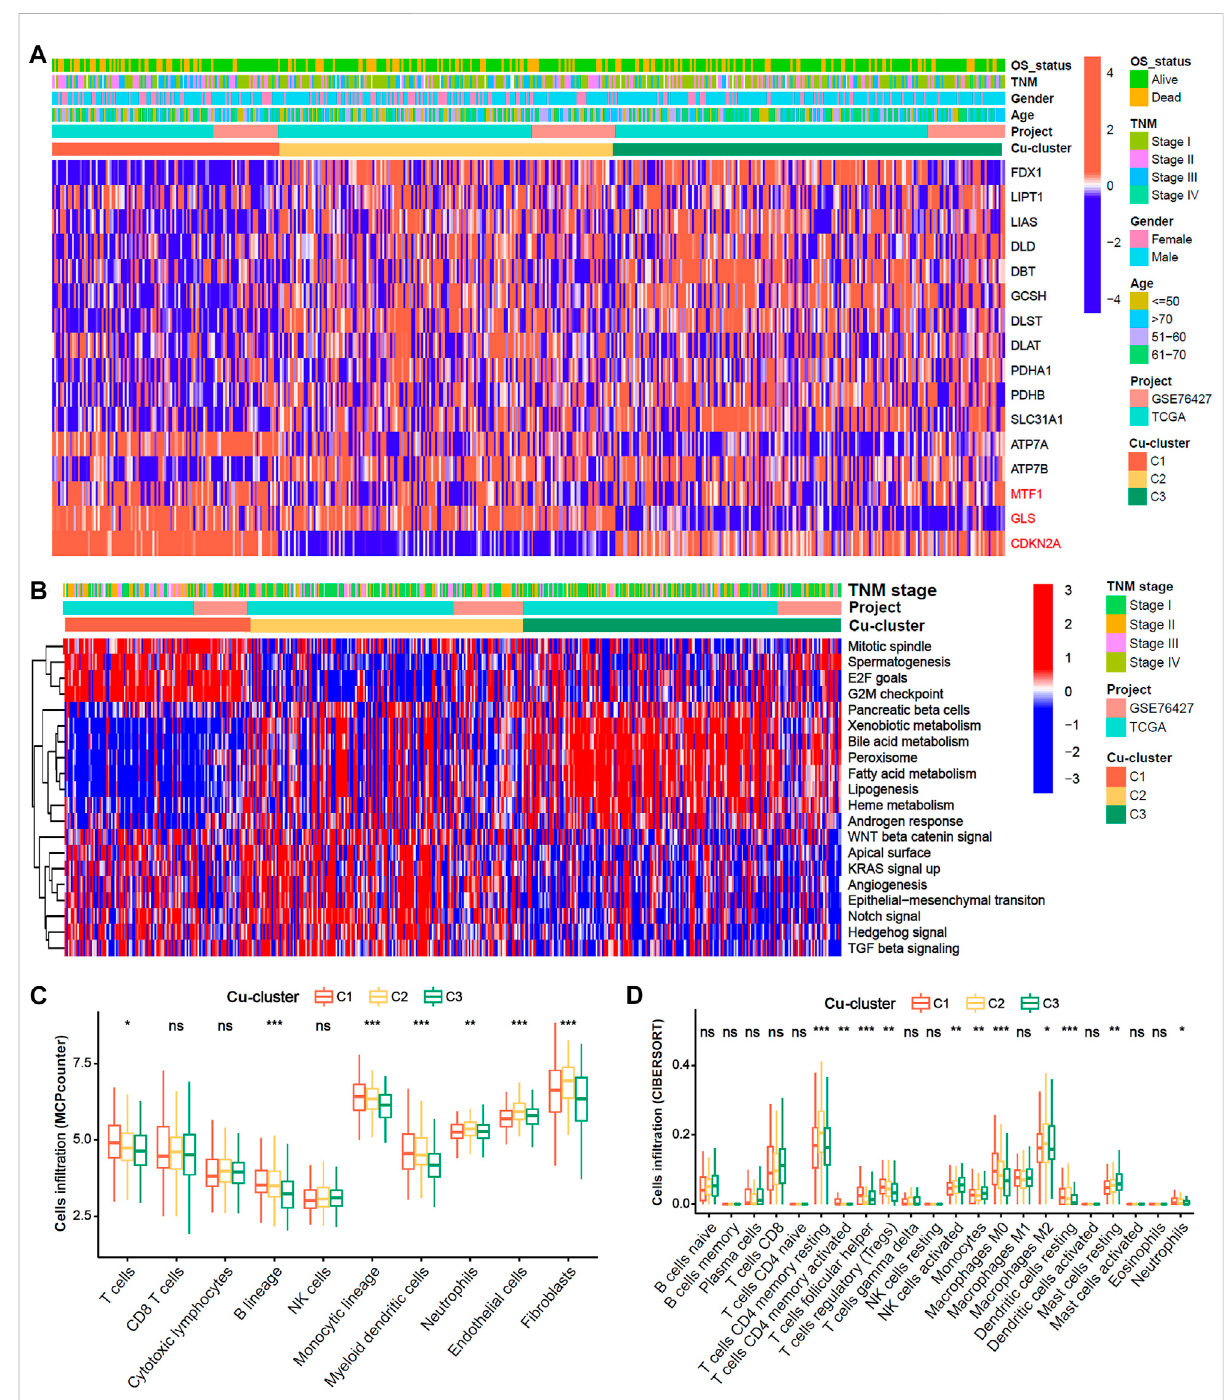
FIGURE 2 Biological characteristics and immune cell in fi ltration characteristics in distinct cuproptosis-clusters. (A) Expression heatmap of 16 Cu-RGs in theTCGA-GEOcohort.ThepatientannotationsofCuproptosis-cluster,OS-status,gender,TNMstage,ageandcohortswerepresentedatthetopof heatmap. (B) GSVA score heatmap of Hallmark pathways among three Cuproptosis-clusters. (C,D) Comparison of immune cell in fi ltration among three Cuproptosis-clusters, which was estimated by MCPcounter (C) and CIBERSORT (D) algorithm,